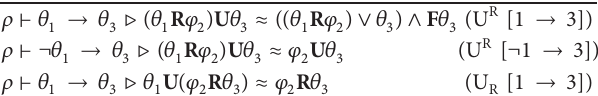
Table 8: Reduction rules for formulae involving adjacent U and R